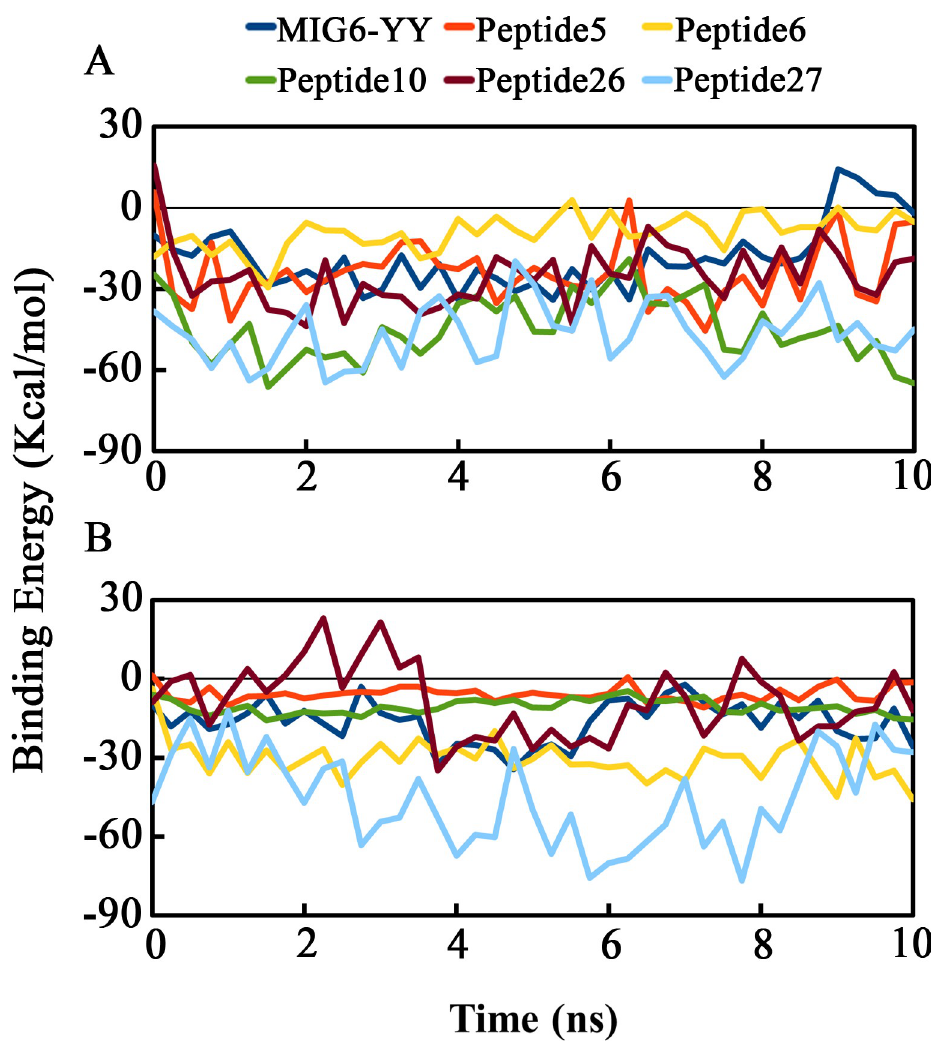
Fig 5. Total binding free energies of both EGFRs in complex with peptides during 10 ns using MM-PBSA method. (A) EGFRL858R and (B) WT-EGFR in complex with MIG6-YY, Peptides 5, 6, 10, 26 and 27. (A) Peptides 5, 10, 26 and 27 have the highest binding affinities to EGFRL858R (-23.923, -44.791, -25.098 and -46.426 Kcal/mol, respectively). (B) peptides 6 and 27 have the highest binding affinities to WT-EGFR (-30.592 and -45.258 Kcal/mol, respectively). Peptide 27 with binding energies (-46.426 and -45.258 Kcal/mol) has similar binding affinities to EGFRL858R and WT-EGFR,